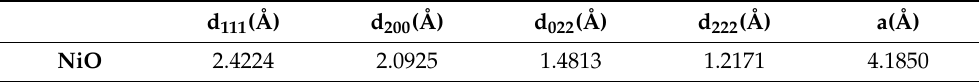
Figure 1. XRD diffractogram of the synthesized NiO films. Table 1. Interplanar distance “d hkl ” and lattice parameter “a” of NiO sprayed thin